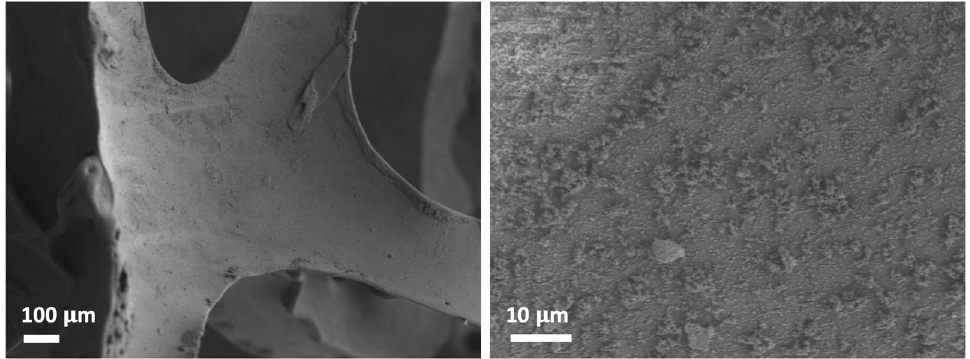
Figure 3. SEM images of as-synthesized EY-APTES@PDA@PUF with di ff erent magni fi cations.